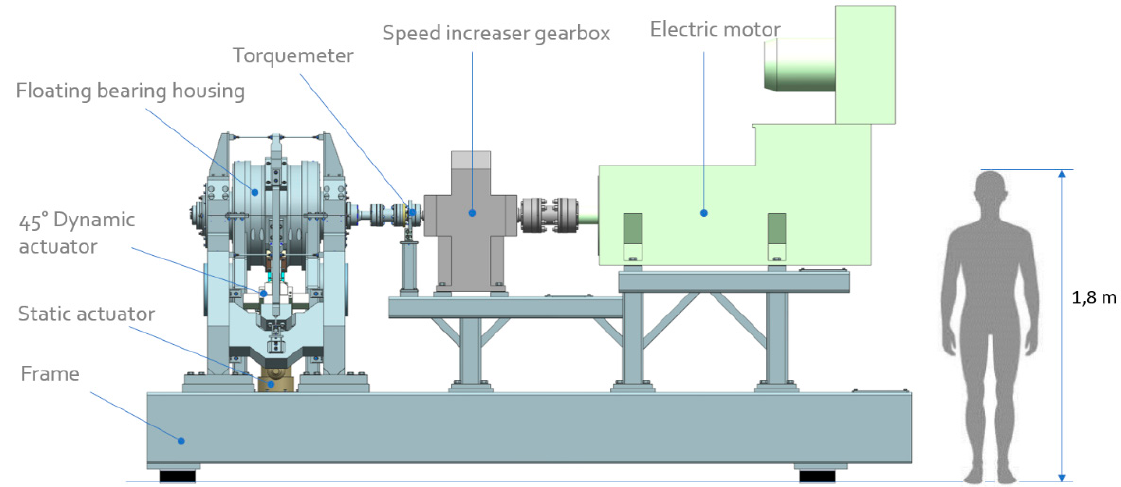
Figure 1. Drawing of the experimental apparatus used for testing TPJB.